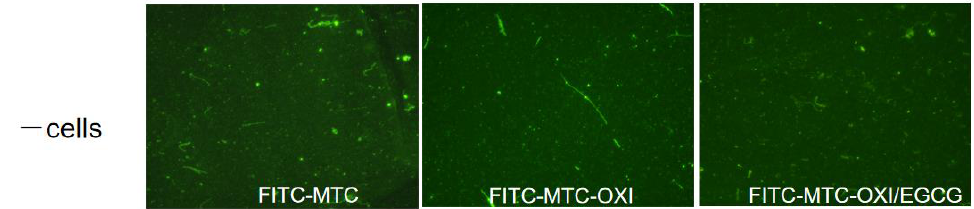
Figure 4. Spontaneous self-assembly of native FITC-MTC, oxidized (FITC-MTC-OXI), and oxidized collagen after EGCG pre-treatment (FITC-MTC-OXI/EGCG) samples.